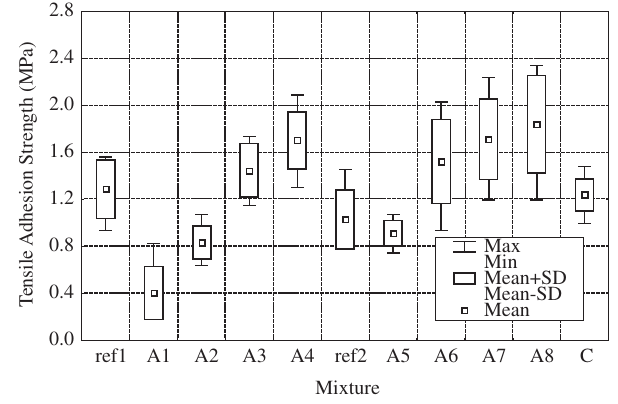
Figure 1. Box plots of the tensile bond strength results. Ref 1 (5% silica, 0% latex); A1 (5% silica, 5% latex); A2 (5% silica 10% latex); A3 (5% silica, 15% latex); A4 (5% silica, 20% latex); ref 2 (10% silica, 0% latex); A5 (10% silica, 5% latex); A6 (10% silica, 10% latex); A7 (10% silica, 15% latex); A8 (10% silica, 20% latex); C (commercial mortar).